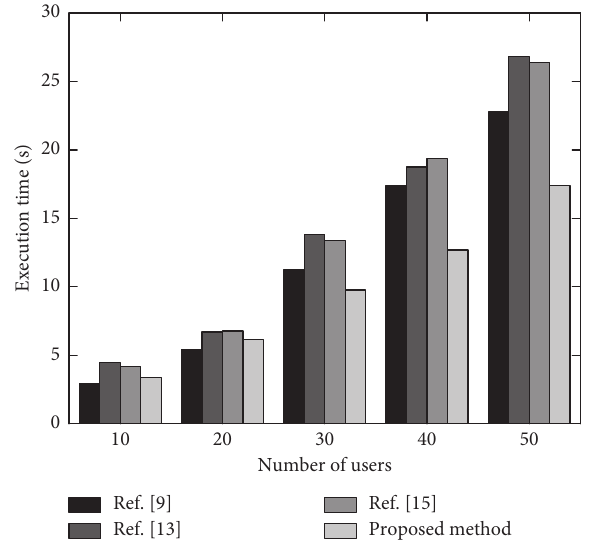
Figure 6: Execution time of different